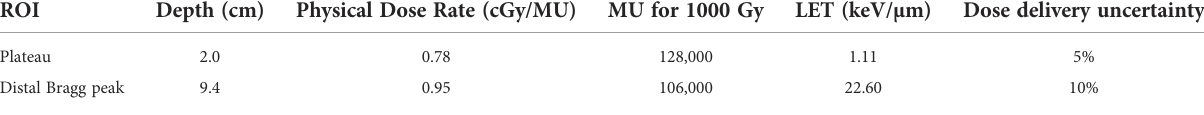
TABLE 1 Calculated doses and corresponding LETs at the two irradiation positions. ROI Depth (cm) Physical Dose Rate (cGy/MU) Plateau Distal Bragg